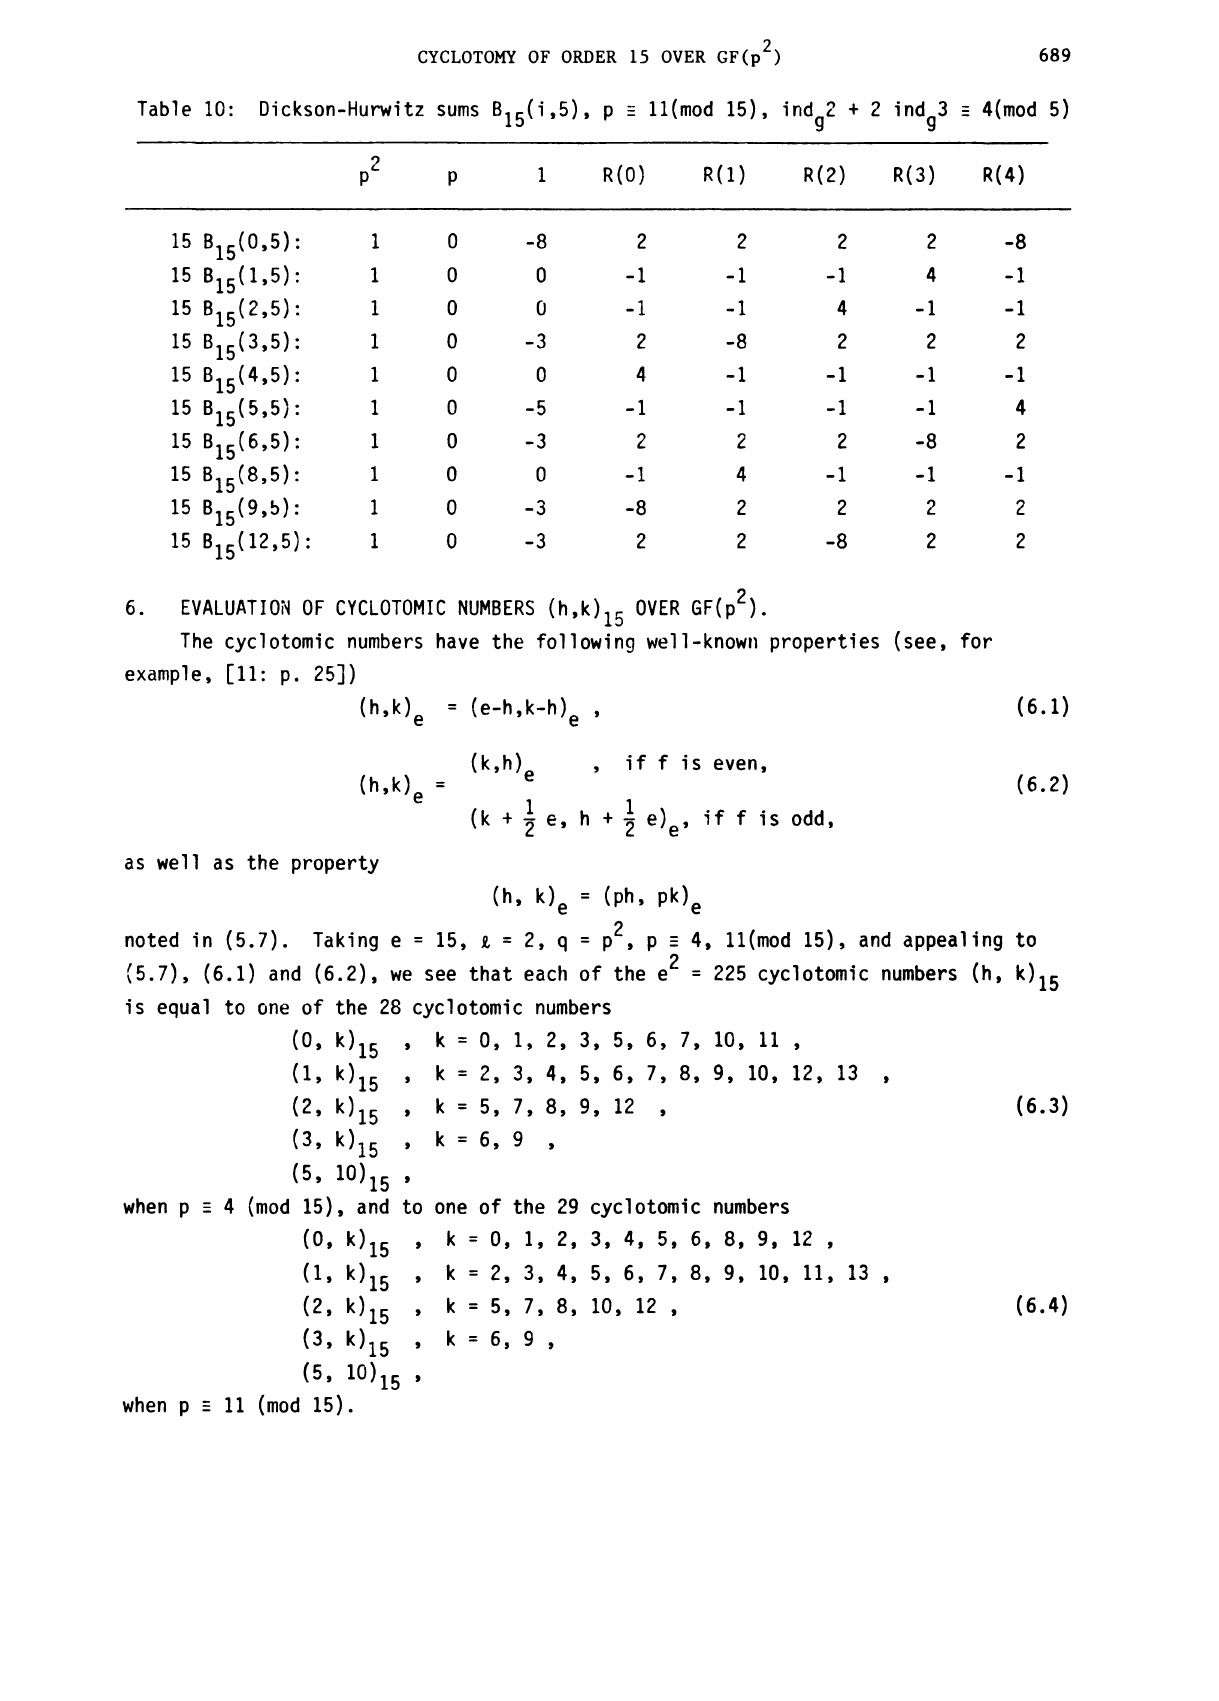
Dickson-Hurwitz sums B15(i,5),